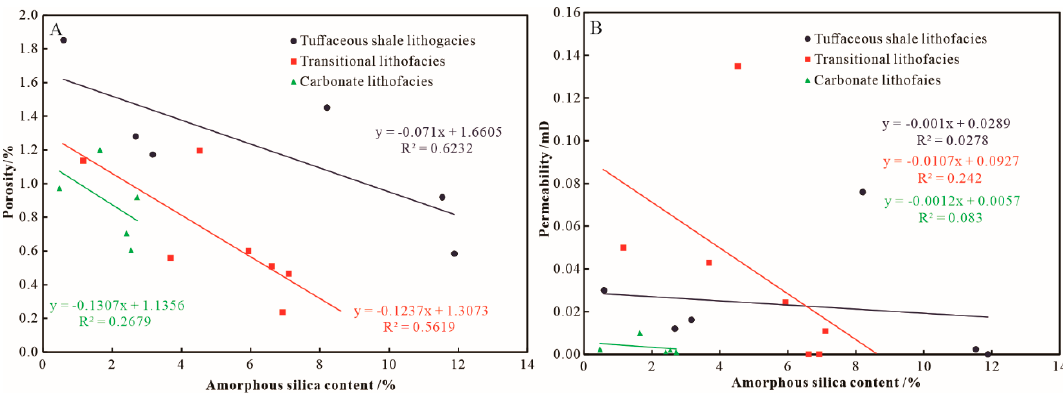
Figure 5. Cross plot of amorphous silica content with ( A ) porosity, ( B ) permeability of different lithofacies in Lucaogou